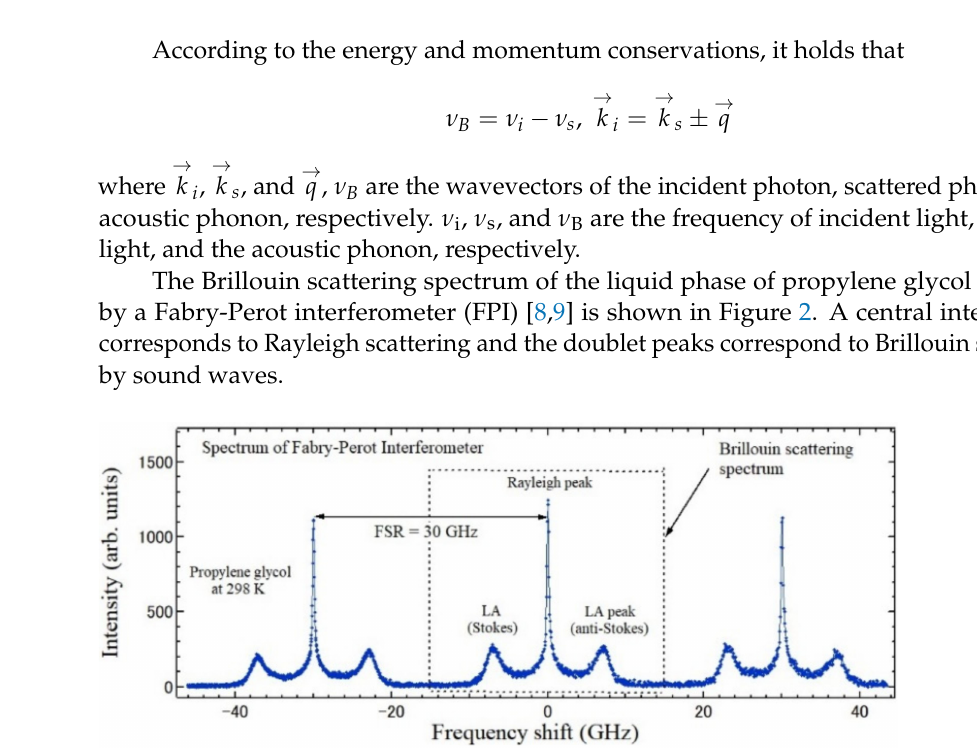
Figure 2. The spectrum of an angular dispersive Fabry-Perot interferometer of propylene glycol in a liquid phase at 298 K with the free spectral range of 30